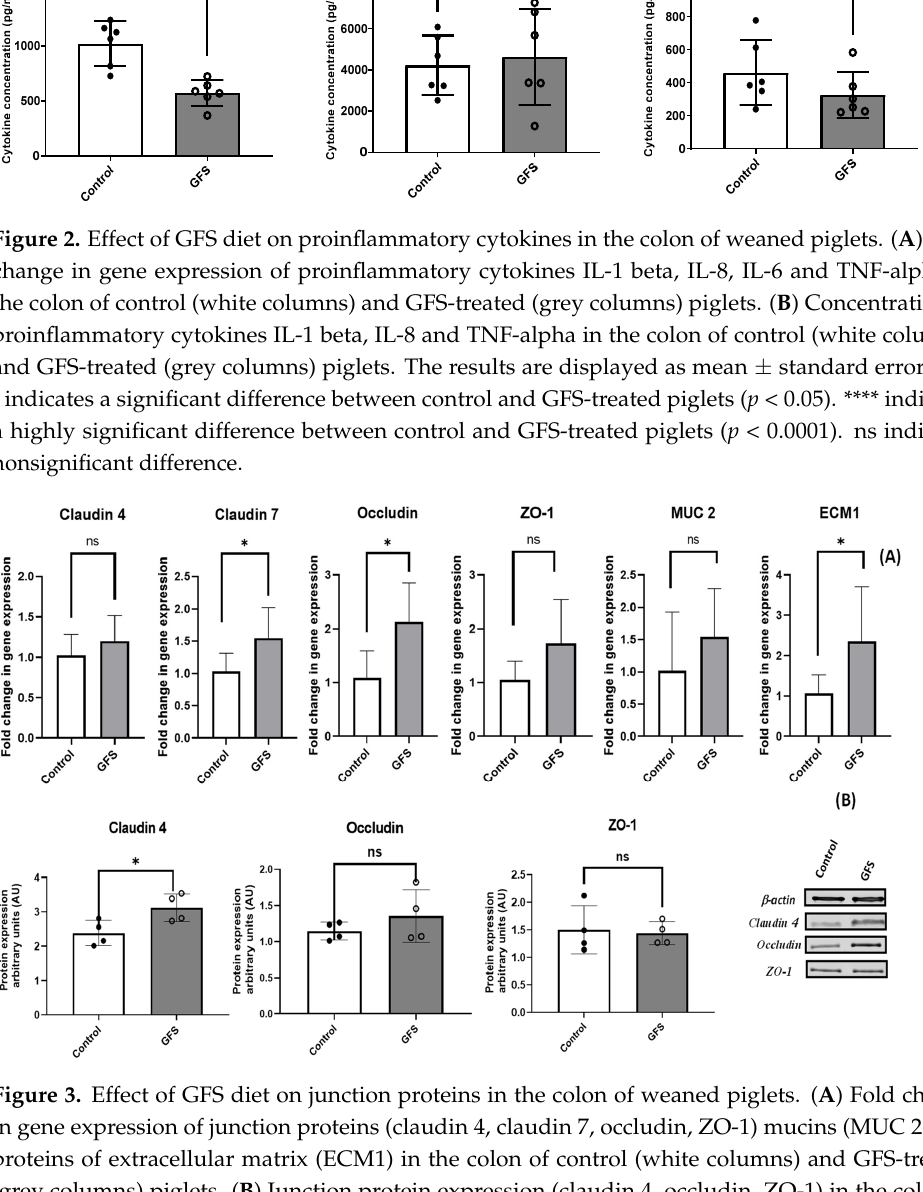
gated (occludin and ZO-1) was not modified by the presence of GFS in the diet (Figure 3B). 3.5. GFS Effect on Selected Microbiota Populations and on Short-Chain Fatty Acids In order to determine the effect of the GFS diet on the intestinal microbiota, the abso- lute abundance of five key microbial strains (Clostridium, Bifidobacterium, Enterobacter, Prevotella and Lactobacillus) relevant for the gut health were investigated in the colonic content of both control and GFS-treated piglets (Figure 4A–E).